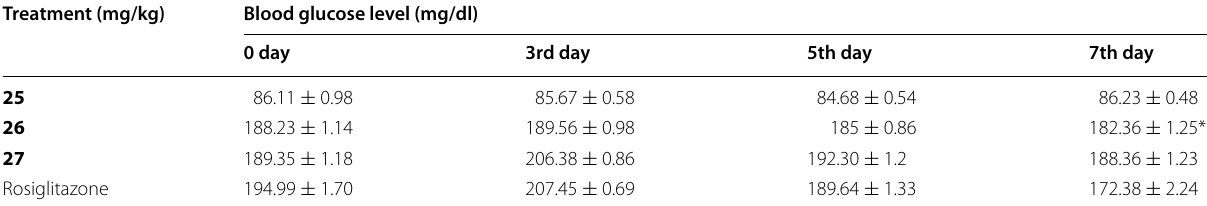
* indicates high reduction in glucose level after seven days